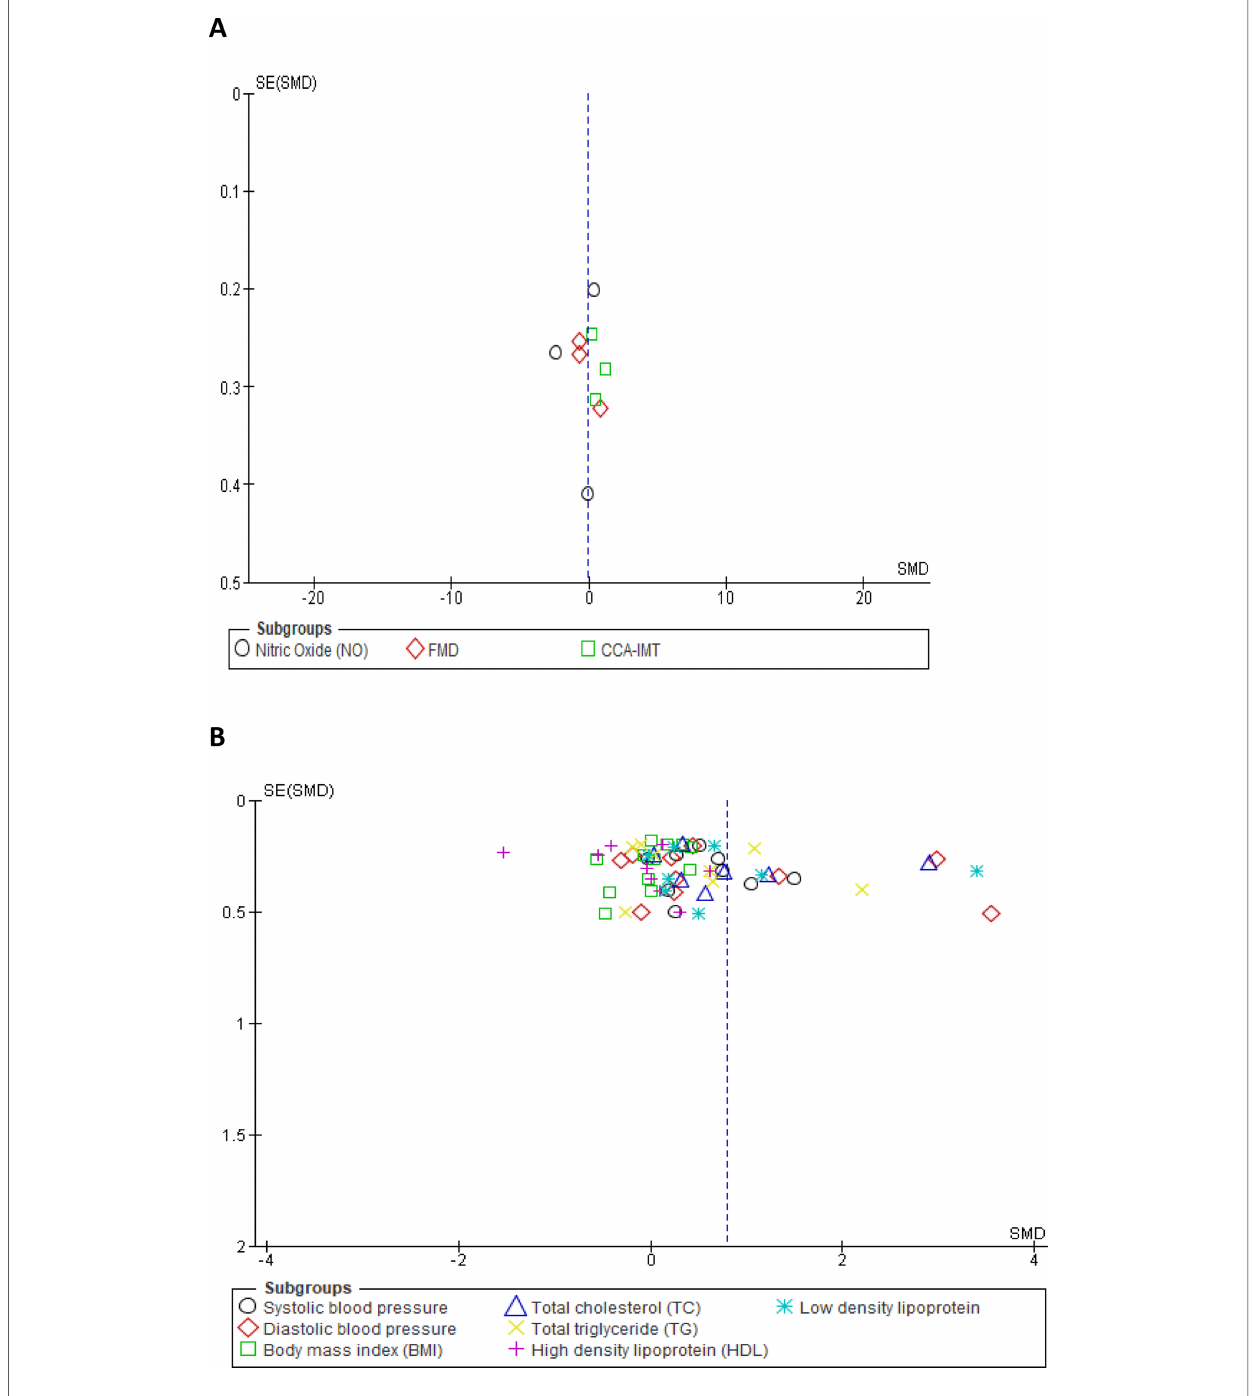
FIGURE 2 Quality assessment of the included